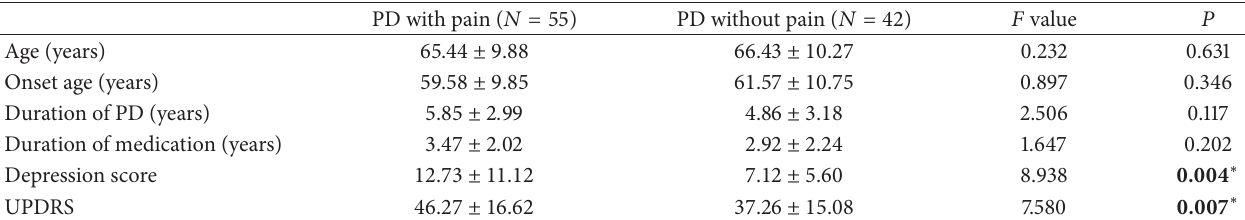
Table 4: Clinical factors on pain in PD